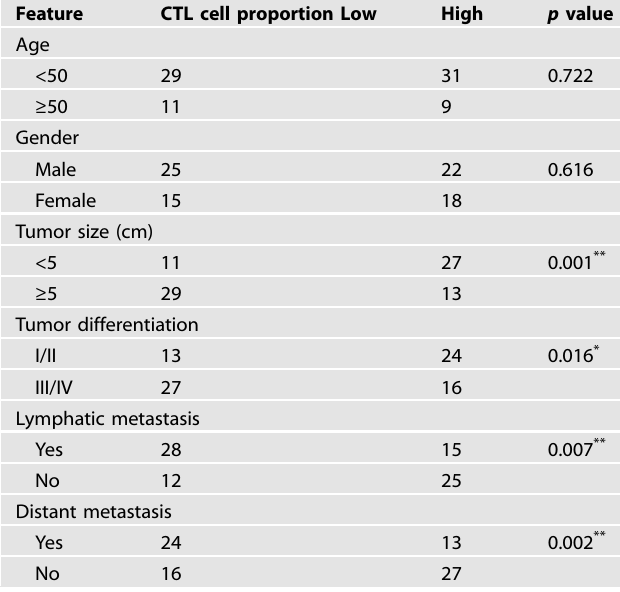
Table 1. Clinical characteristics of LUAD patients according to CTL cell